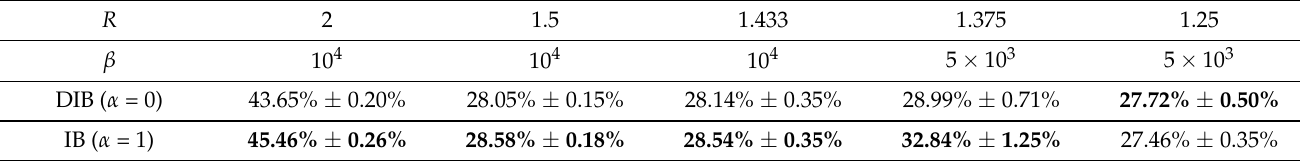
Table 3. The standard error of the mean (SEM) is in parentheses. Table 3. The average error rate of classification between representation samples on two domains with difference noise levels. A larger error rate indicates smaller RD. The highest error rate under each noise levels are marked in